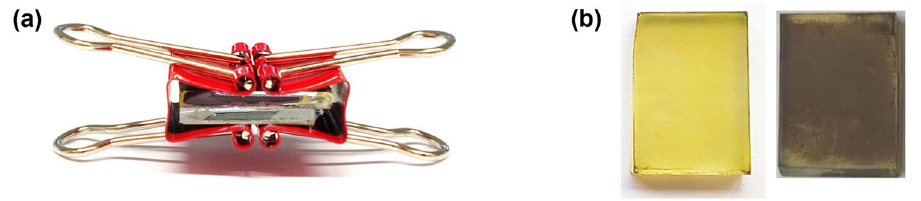
Figure 1. ( a ) Perovskite-coated substrate in physical contact for PCA. ( b ) color change of the FAPbI 3 sample from yellow (as-prepared) to grey (after 20 h